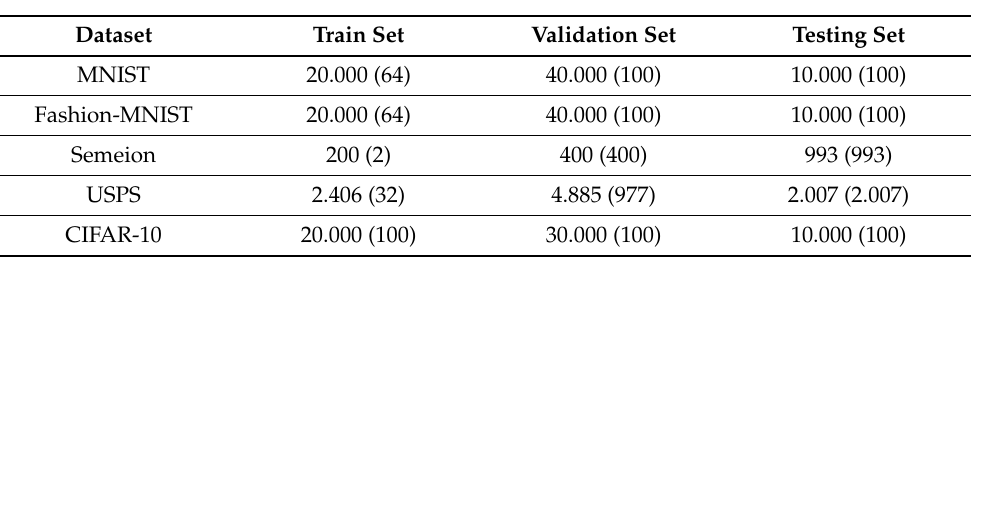
Table 15. Datasets split into training, validation, and testing, along with the batch